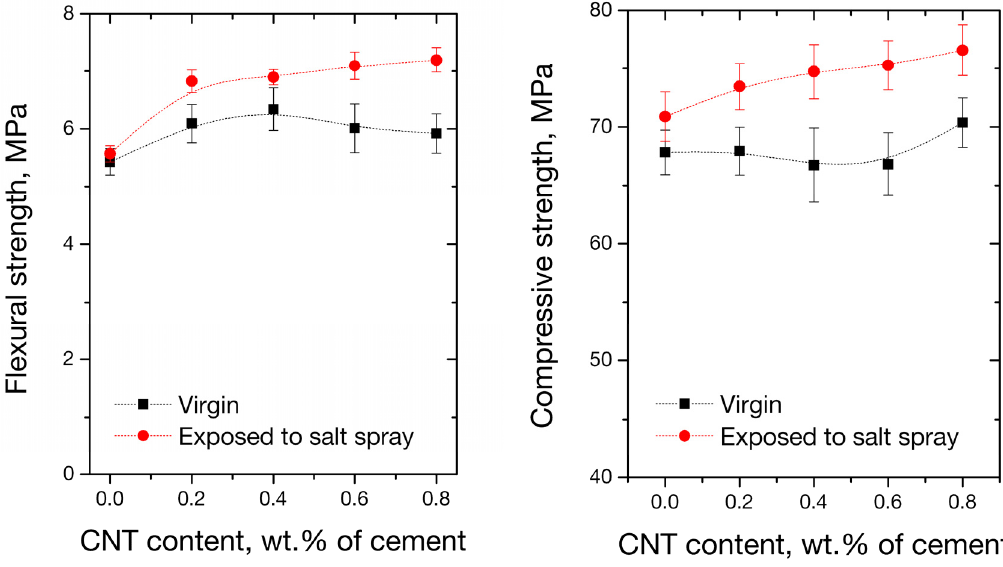
Figure 12. Mechanical properties of the nano-modified mortars before and after the exposure to the salt spray chamber.